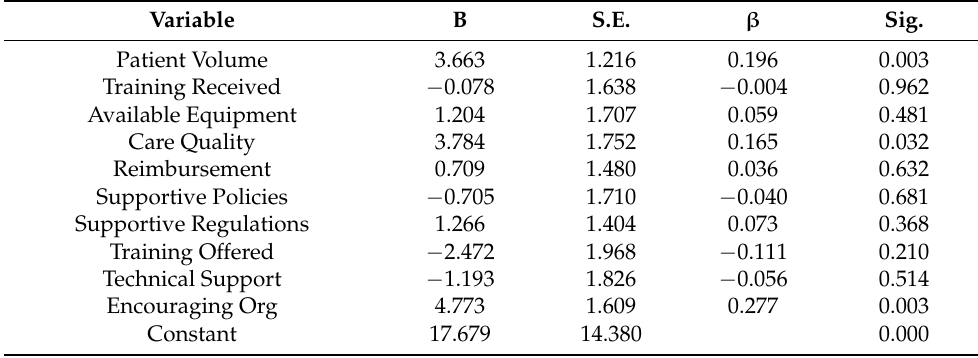
Table 5. Multiple regression of facilitators of telemedicine